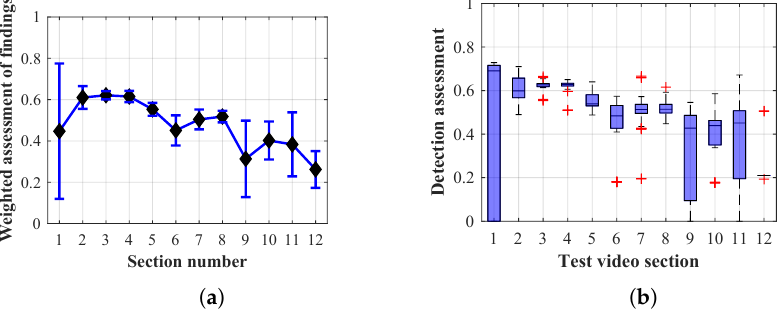
Figure 30. Results of Method 1.2 with a lifespan of 1 frame. ( a ) the weighted average rating with the average mean absolute error of the weighted rating and ( b ) boxplots of the distribution of the statistical sets of the results of the individual sections evaluated indicating: minimum, 1st quartile, median, 3rd quartile, maximum.